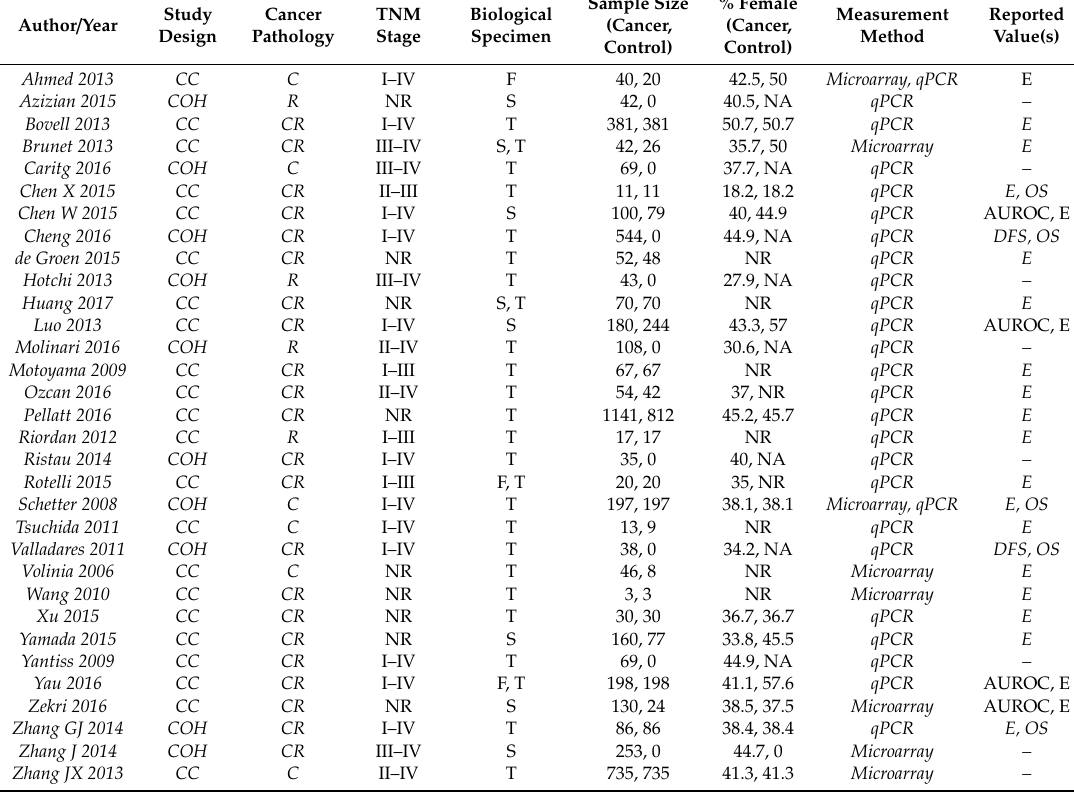
Table 1. Basic characteristics of included studies. CC, case control; COH, cohort; C, colon; R, rectum; CR, colorectal; NR, not reported; F, feces; T, tumor; S, serum; E, miR-20a expression; OS, overall survival; DFS, disease-free survival; AUROC, area under the receiver operating characteristic